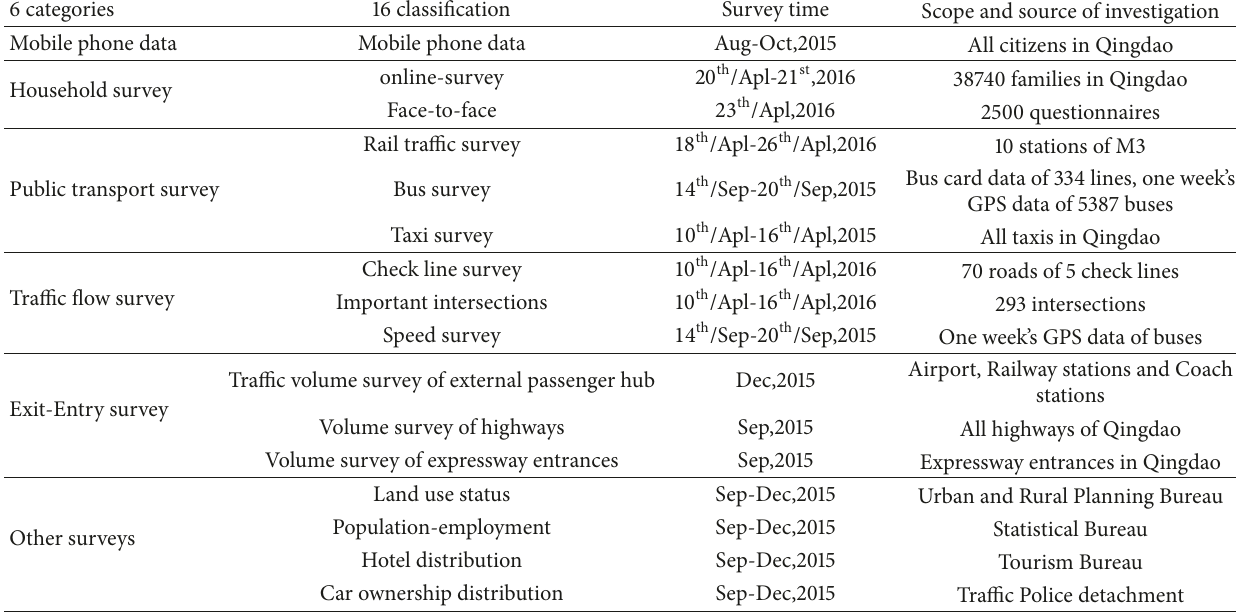
Table 1: Traffic survey